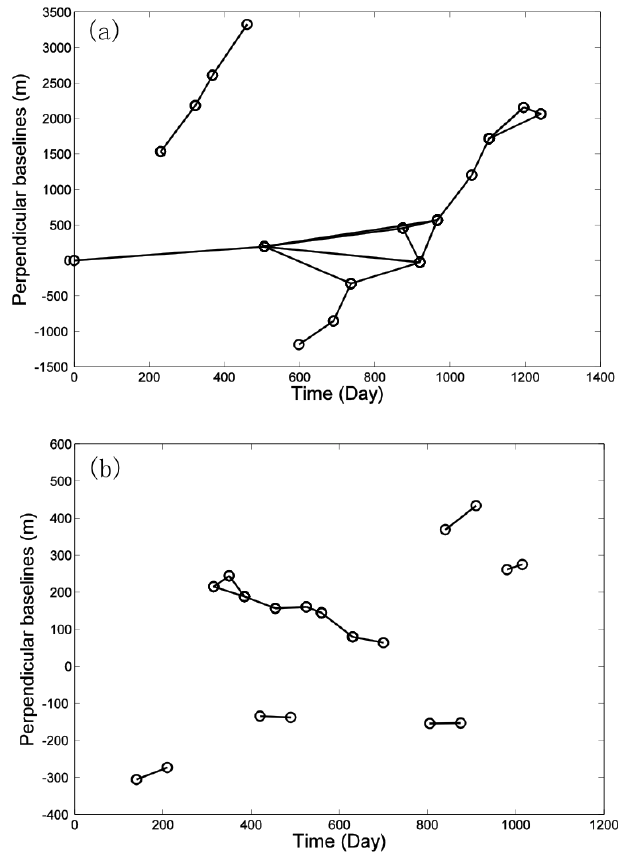
Figure 7. Spatial-temporal baselines of the generated ALOS ascending ( a ) and ENVISAT descending ( b ) interferograms. Circles and lines represent SAR images and interferometric pairs, respectively.